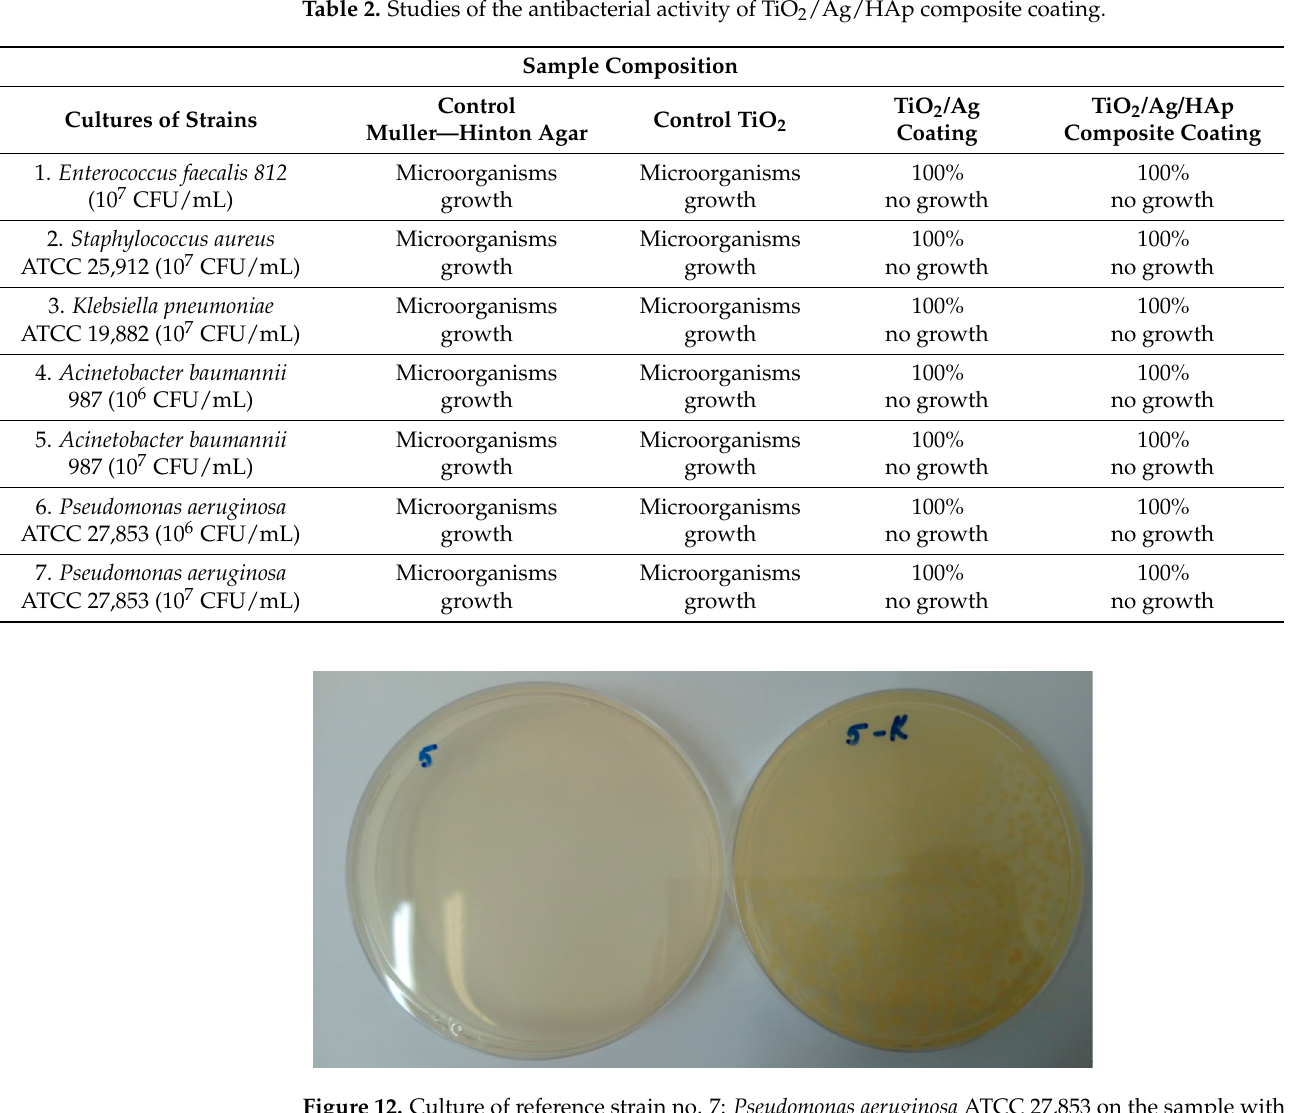
Table 2. Studies of the antibacterial activity of TiO 2 /Ag/HAp composite coating.